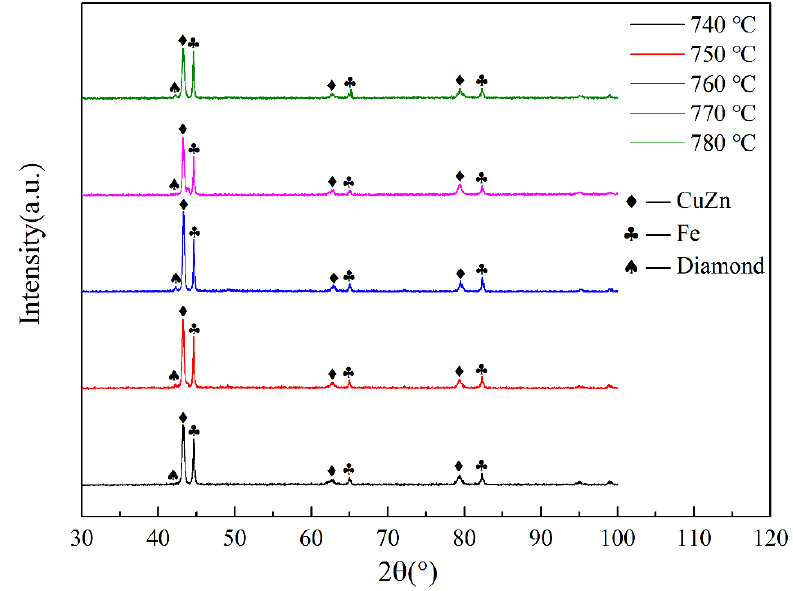
Figure 2. XRD pattern of AD/Cu-Fe sandwich composite. Compared with the standard PDF (Powder Diffraction File) card, the results showed peaks at 2 θ values of 43.3 ◦ , 63 ◦ , and 79.5 ◦ correspond to the (110), (200), and (211)